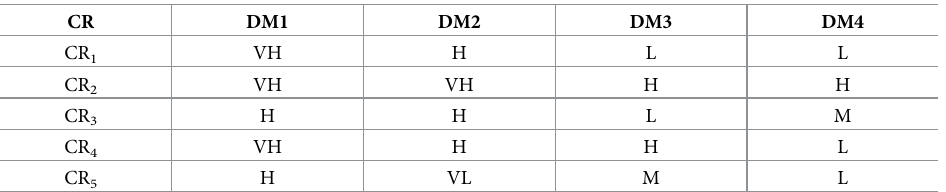
Table 3. Linguistic evaluations of CRs by DM